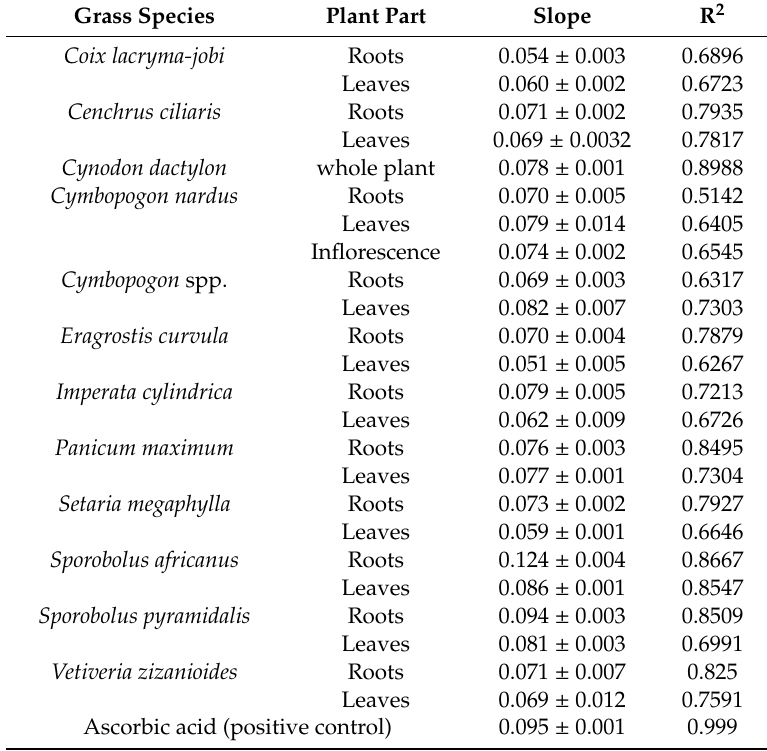
Table4. Ferric-reducingantioxidantpower(FRAP)ofgrassesusedinSouthAfricantraditionalmedicine. Grass Species Plant